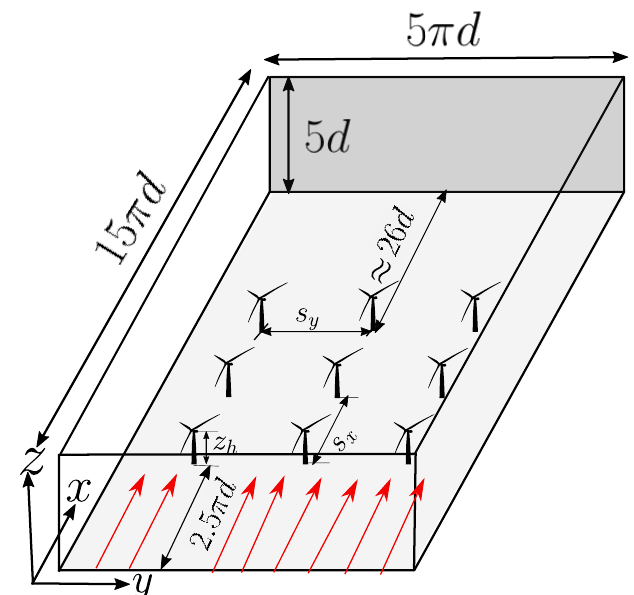
Figure 1. Schematic of the 3 3 wind turbine array. Inter-turbine distance, s x = 7 d , s y = 3 d . ×